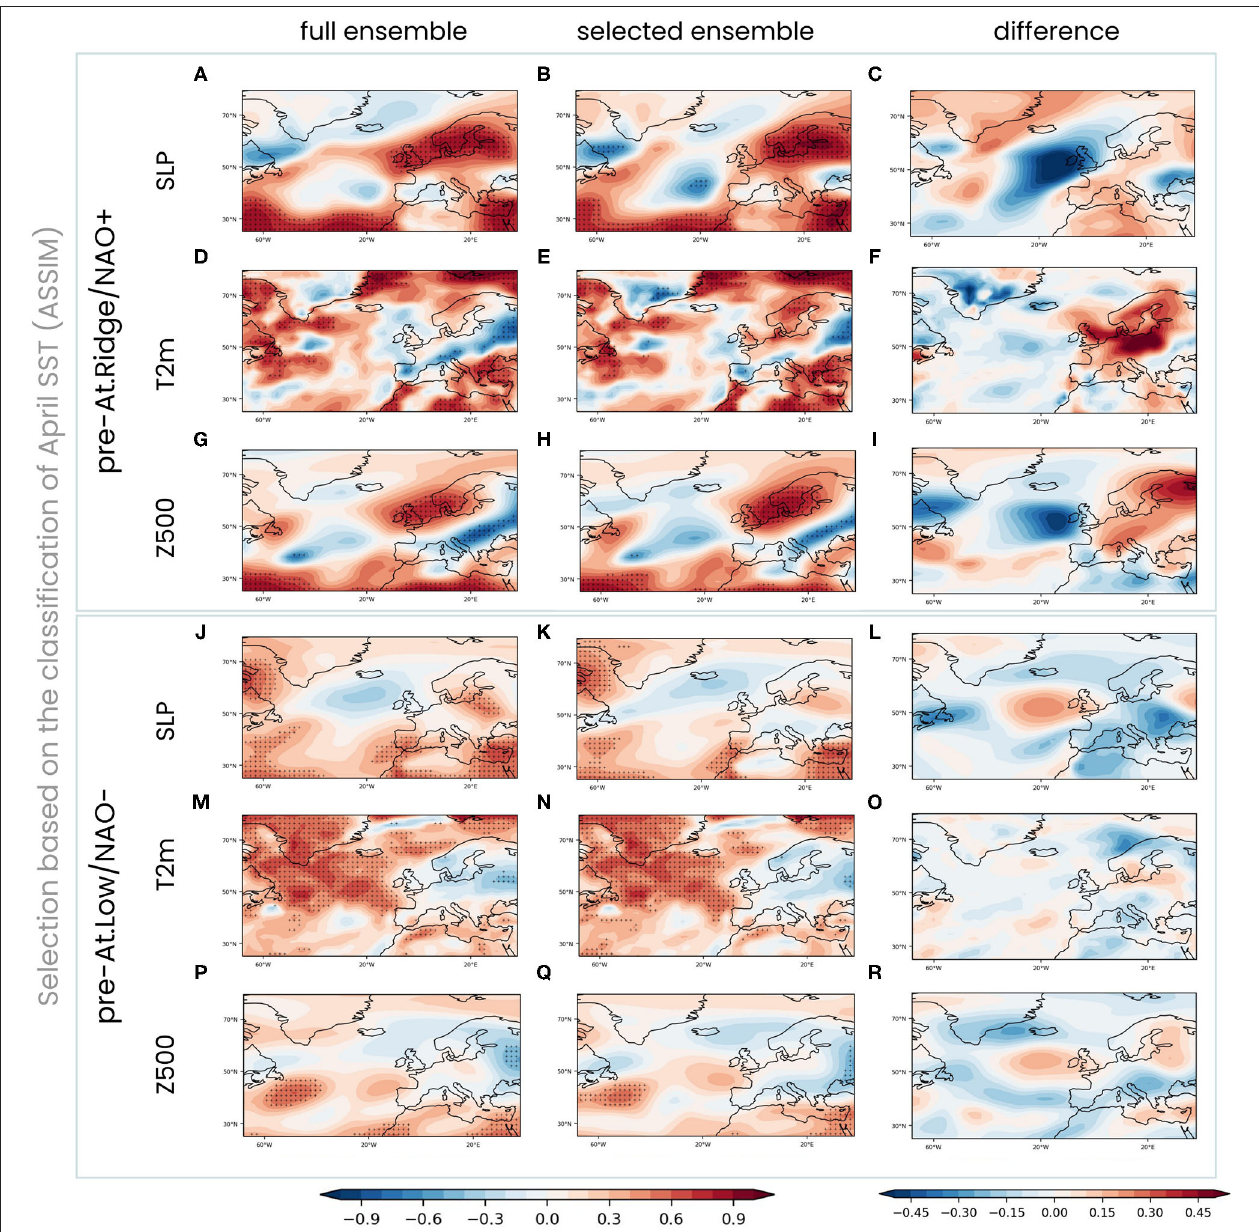
FIGURE 8 | Evaluation of SST as a predictor in the independent ensemble. ACC for SLP, temperature at 2 m height (T2m), and geopotential height at 500 hPa (Z500), as labeled, comparing the independent ensemble to Era-Interim in 1980–2016. On the upper three rows, ACCs are calculated for years where April SST months in the pre-forecast data are classified as preceding either At.Ridge or NAO + , i.e., pre-At.Ridge/NAO + . Conversely, the lower three rows show ACCs for the case of pre-Atl.Low/NAO-. Column-wise, ACCs are presented as follows: (A,D,G,J,M,P) the ensemble mean is taken over the full ensemble; (B,E,H,K,N,Q) the ensemble mean is taken over the selected ensemble; (C,F,I,L,O,R) differences in ACC between the full and selected ensemble mean. Stippling represents correlation significant at the 95% level.